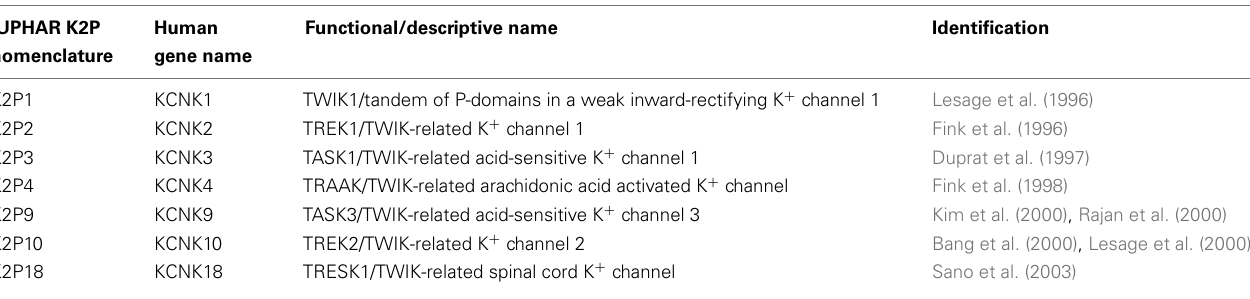
Table 1 |The nomenclature of K2P